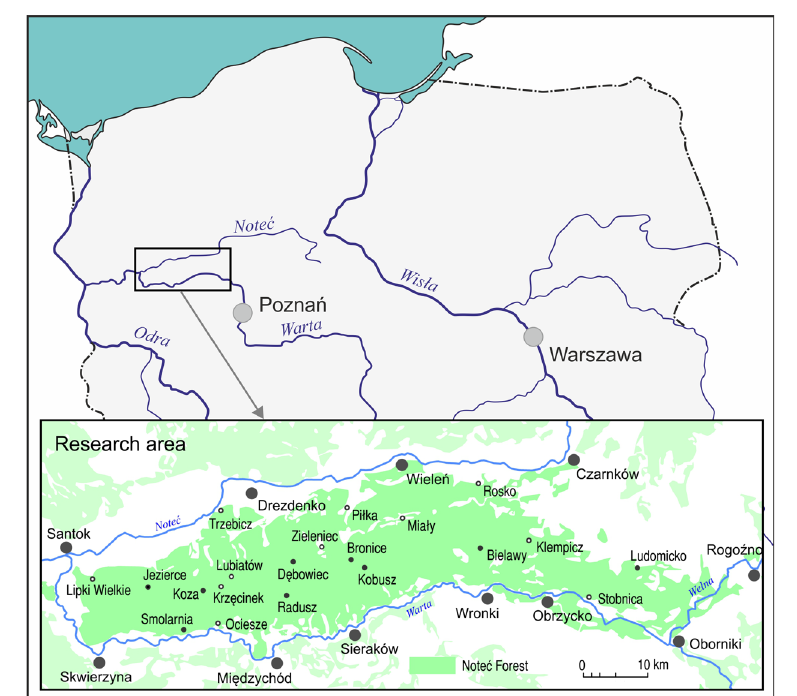
Fig. 1. Location of the research area. Prepared on the basis of the Geographical Objects